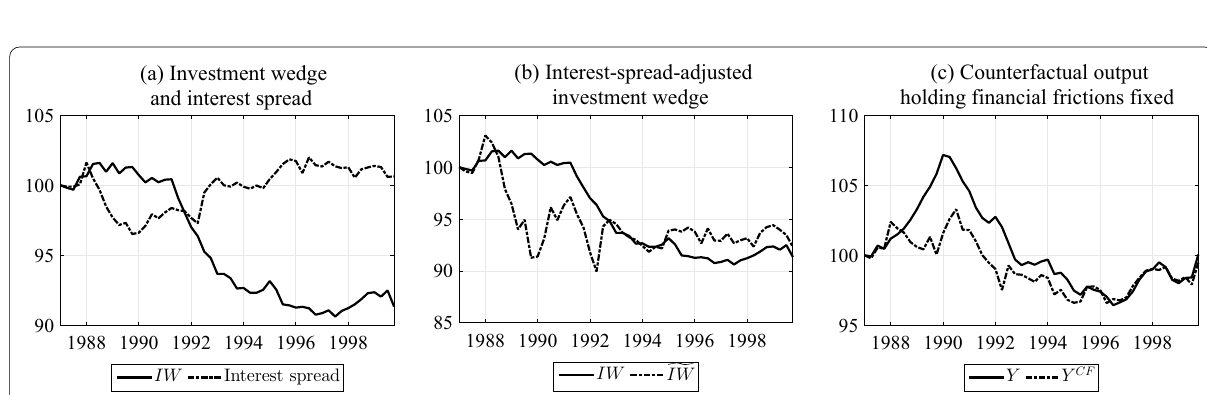
Fig. 25 Robustness: The role of disruptions in financial intermediation for σ ω = 0.30 (1987Q1–1999Q4). IW denotes the investment wedge, the interest spread corresponds to the spread between the lending and deposit rates obtained from the IMF International Financial Statistics, and is the interest-spread-adjusted investment wedge. Y is output and Y CF denotes the counterfactual path of output when holding financial